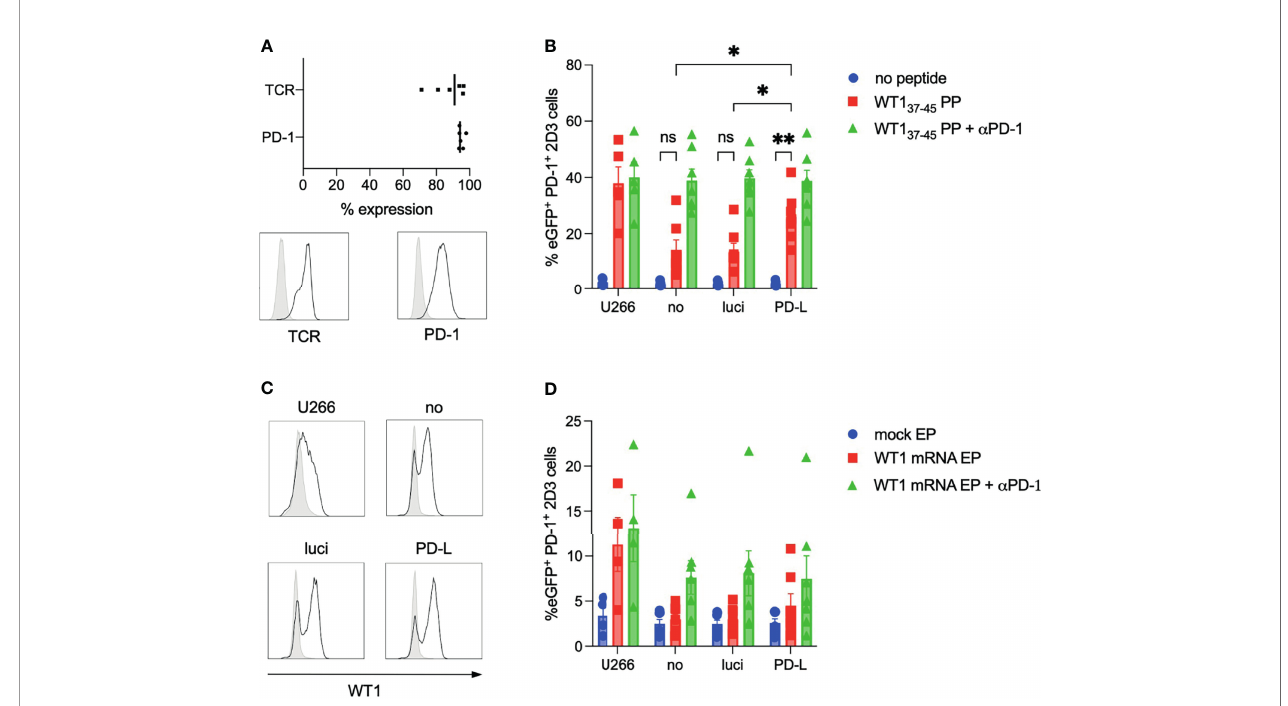
FIGURE 4 | Improved WT1-speci fi c T cell activation by silencing of PD-1 ligands in a model PD-1 + 2D3 T-cell model assay. (A) Percentage of PD-1 and TCR ab surface expression in TCR ab -de fi cient, PD-1-transduced and WT1 37-45 TCR mRNA-electroporated 2D3 cells (n = 6, upper panel) and representative histogram overlays (lower panel) of TCR ab and PD-1 staining (black line) with their respective isotype (grey fi lled line). (B) Percentage of eGFP-expressing 7-AAD - CD8 + PD1 + 2D3 cells (n = 7) after overnight co-culture with untreated (no), control siRNA (luci) and PD-L siRNA (PD-L) IL-15 DCs that were either left unpulsed (no peptide) or pulsed with WT1 37-45 peptide (PP). In a third condition, IL-15 DCs were peptide pulsed and neutralizing anti-PD-1 antibody (nivolumab) was added to the co-culture (WT1 37-45 PP + a PD-1). (C) Representative histogram overlays of intracellular WT1 expression 4 hours after WT1 mRNA electroporation (black line) versus mock (no mRNA) electroporation (grey fi lled line) of control APCs U266 cells and untreated (no), control siRNA (luci) and PD-L siRNA (PD-L) IL-15 DCs. (D) Percentage of eGFP-expressing 7-AAD - CD8 + PD1 + 2D3 cells (n = 7) after co-culture with mock-electroporated or WT1 mRNA-electroporated PD-L - U266 cells or untreated (no), control siRNA (luci) or PD-L siRNA (PD-L) IL-15 DCs. Additionally, co-cultures with WT1 mRNA-electroporated APCs were pre-incubated with nivolumab. eGFP, enhanced green fl uorescent protein; EP, electroporation; ns, not signi fi cant; PD-1, programmed death-1; TCR, T-cell receptor; WT1, Wilms ’ tumor protein-1. *, 0.05; **, 0.01; NS, not signi fi